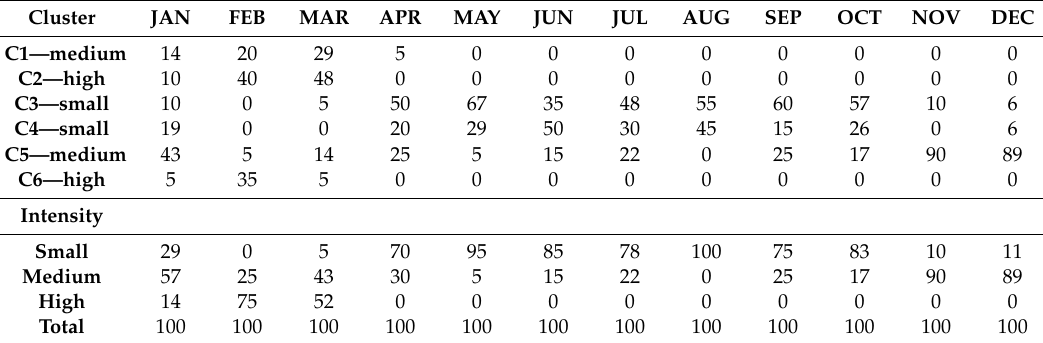
Figure 12. The typical energy consumption profiles associated with each cluster. Table 7. The measurement of the intensity in each month, in